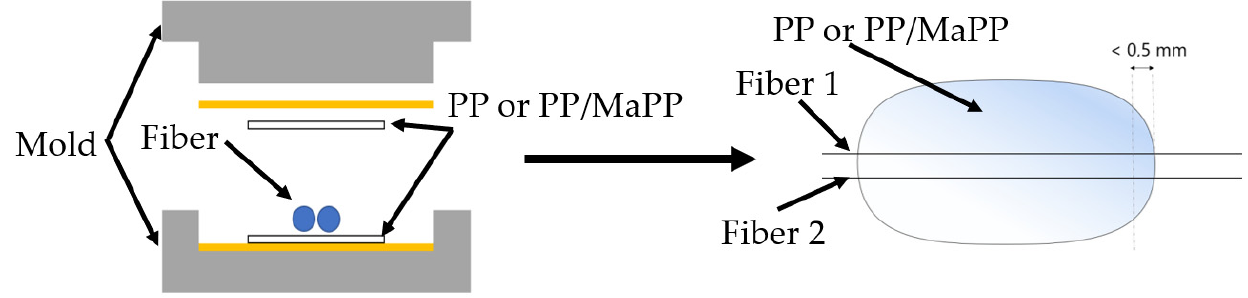
Figure 2. Tool for embedding the fibers between two matrix films ( left ) and a sample with embedded fibers ( right ).